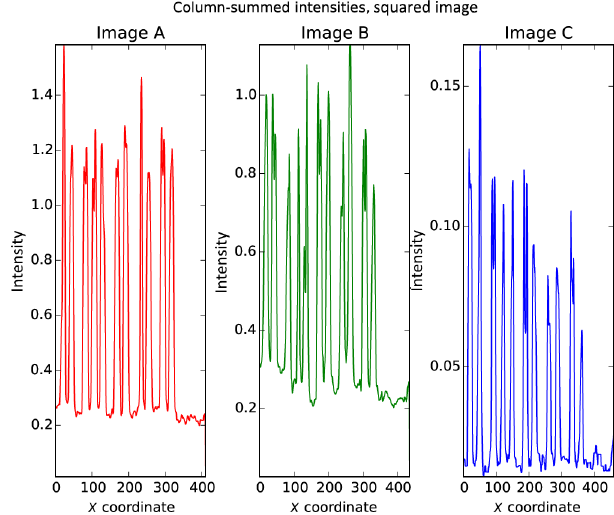
Figure 8. The column-summed intensities of the clock displays of images A, B and C (Figs. 4, 5 and 6) after median filtering.